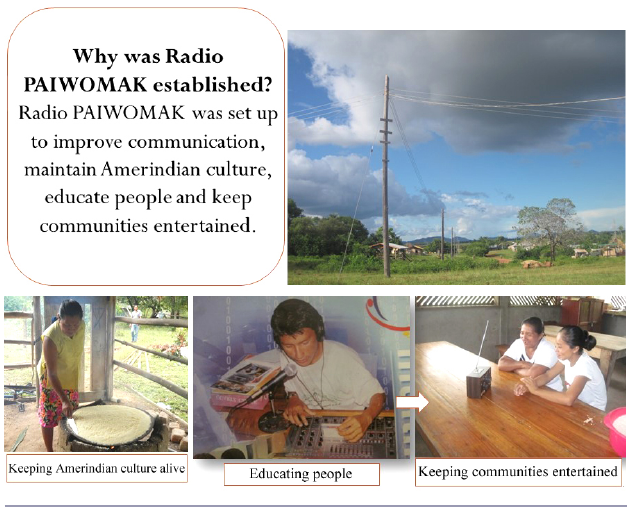
Fig. 5 . Uses of the community radio station depicted in the adaptability best practice